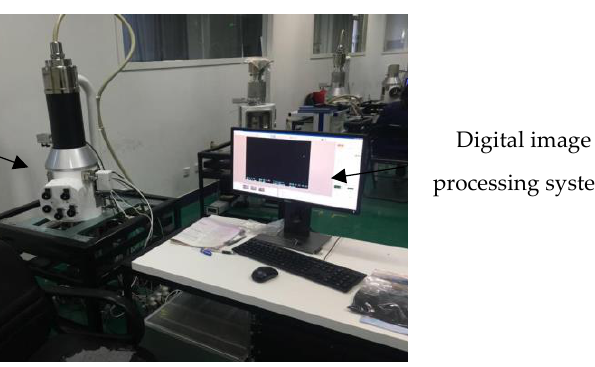
Figure 2. KYKY-EM6200 tungsten filament scanning electron microscope.